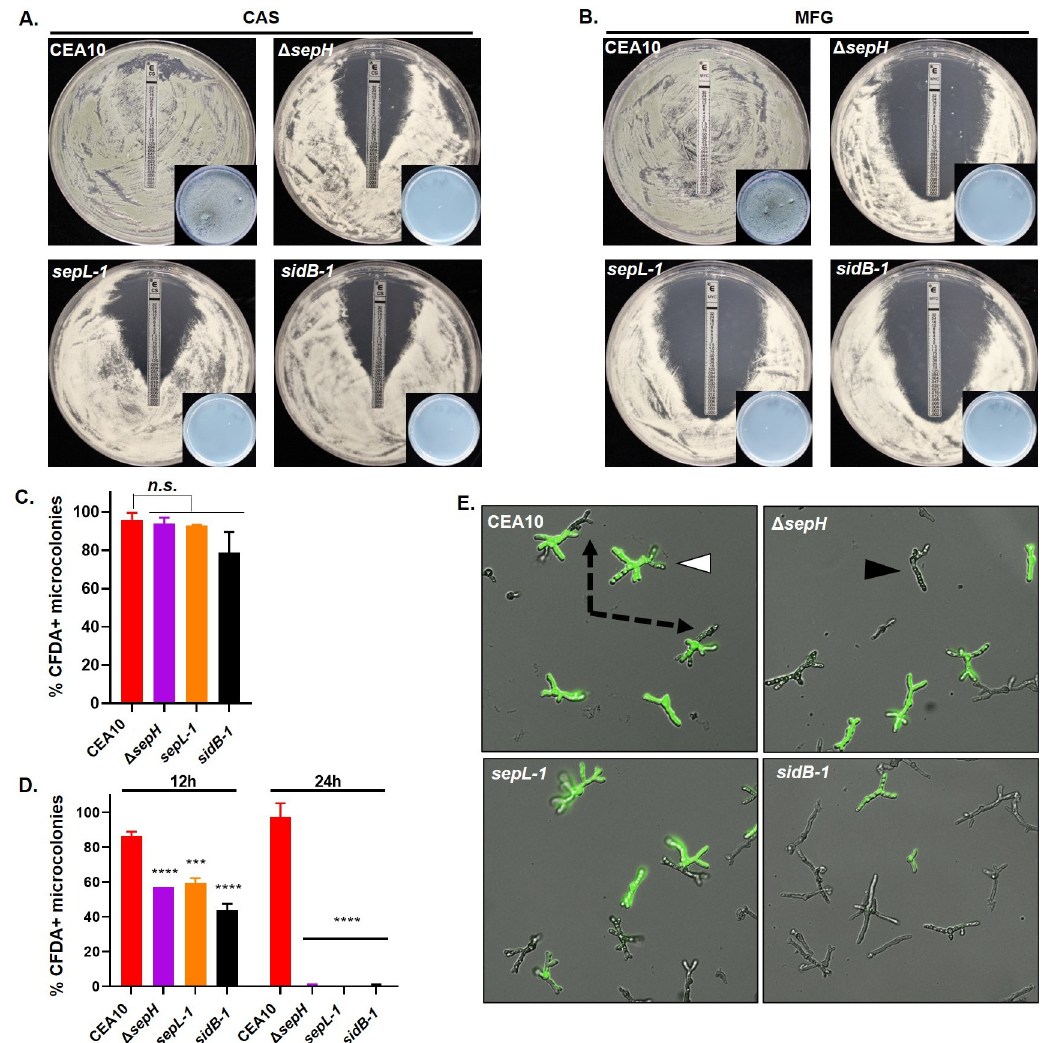
Fig 5. The A . fumigatus SIN kinases are required for survival under echinocandin stress. A, B) Loss of sepH , sepL , or sidB increases susceptibility to echinocandins in a modified E-test assay. 1 x 10 6 total conidia in 500 μ l sterile water from the wild type parent (CEA10), the sepH deletion ( Δ sepH ), or the sepL ( sepL-1 ) or sidB ( sidB-1 ) disruption strains were spread evenly over GMM agar plates. E-test strips for caspofungin ( A ) or micafungin ( B ) were applied and assays incubated for 48 hrs. Note the zone-of- clearance with no detectable growth for the Δ sepH , sepL-1 and sidB-1 mutants in the presence of either echinocandin. Insets show representative, drug-free minimal media culture plates onto which a single agar plug from the zone-of-clearance for each assay was sub-cultured. Multiple agar plugs (n = 10), taken from within 1 cm of the E-test strip and between the 32 and 0.25 ug/ml markers, were sub-cultured in the same manner for each assay. Note lack of growth for the SIN kinase mutant subcultures. CAS = caspofungin, MFG = micafungin. C) Quantitation of viability by CFDA staining of the CEA10 control and SIN kinase mutants in the absence of echinocandin stress. Conidia from each strain were germinated for 12 hrs and subsequently stained with 5-carboxyfluorescein diacetate (CFDA) to detect live hyphal elements. D) Quantitation of viability by CFDA staining of the strain set in the presence of caspofungin. Conidia from each strain were cultured for 12 hrs and 24 hrs at 37˚C in the presence of 0.5 μ g/ml caspofungin and subsequently stained with CFDA to detect live microcolonies. CFDA positivity was scored for 100 microcolonies in each experiment and all assays were completed in triplicate. Data were averaged for each strain and treatment. One-way ANOVA and Dunnett’s multiple comparisons post hoc analyses indicated differences in CFDA staining in the absence of micafungin were not significant (n.s.), whereas the Δ sepH , sepL-1 and sidB-1 mutants were significantly less viable after 12 and 24 hrs growth in the presence of caspofungin. ���� p < 0.0001; ��� p = 0.0001. E) Echinocandin stress during early growth stages leads to death of the SIN kinase mutants. White arrowhead denotes example of a microcolony stained positive with CFDA (bright green). Black arrowhead denotes a CFDA-negative microcolony. Dash-lined arrows denote dead (CFDA-negative) hyphal compartments of CFDA-positive microcolonies only seen in the CEA10 control.